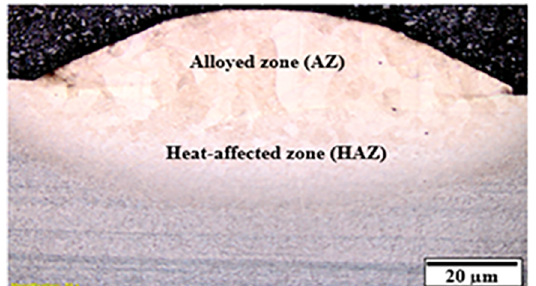
Figure 5. Optical micrograph of sample MB1 showing geometrical